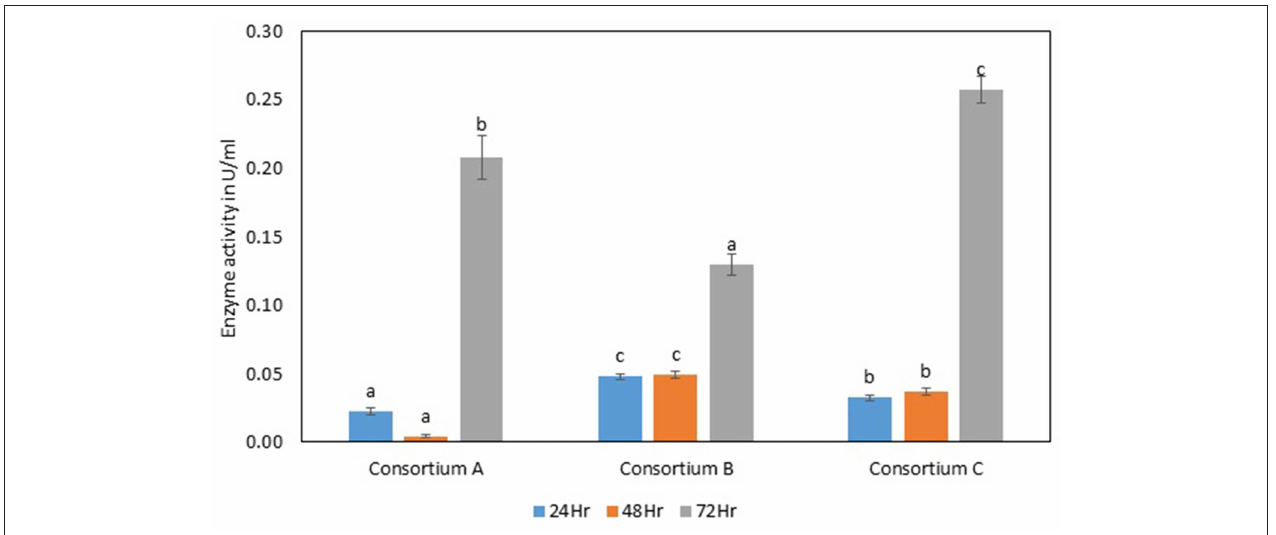
FIGURE 8 | Endoglucanase activity of different consortia. Values are the mean ± SE (standard error). Mean values in each bar with the same alphabet superscript(s) do not differ significantly, but different alphabet superscript is showed significantly different between each treatment by Duncan post hoc test ( p ≤ 0.05).